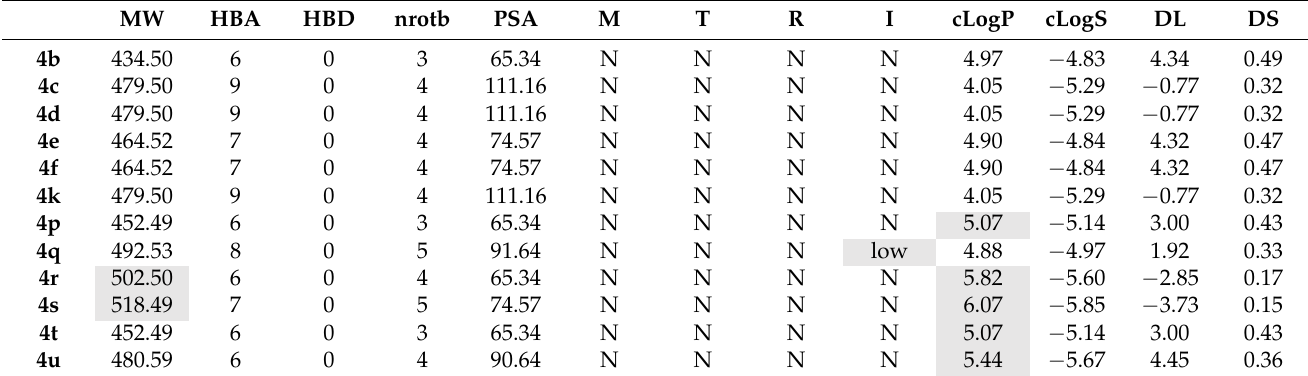
Table 4. Theoretical prediction of ADME properties. Theoretical prediction of adsorption, distribution, metabolism, and